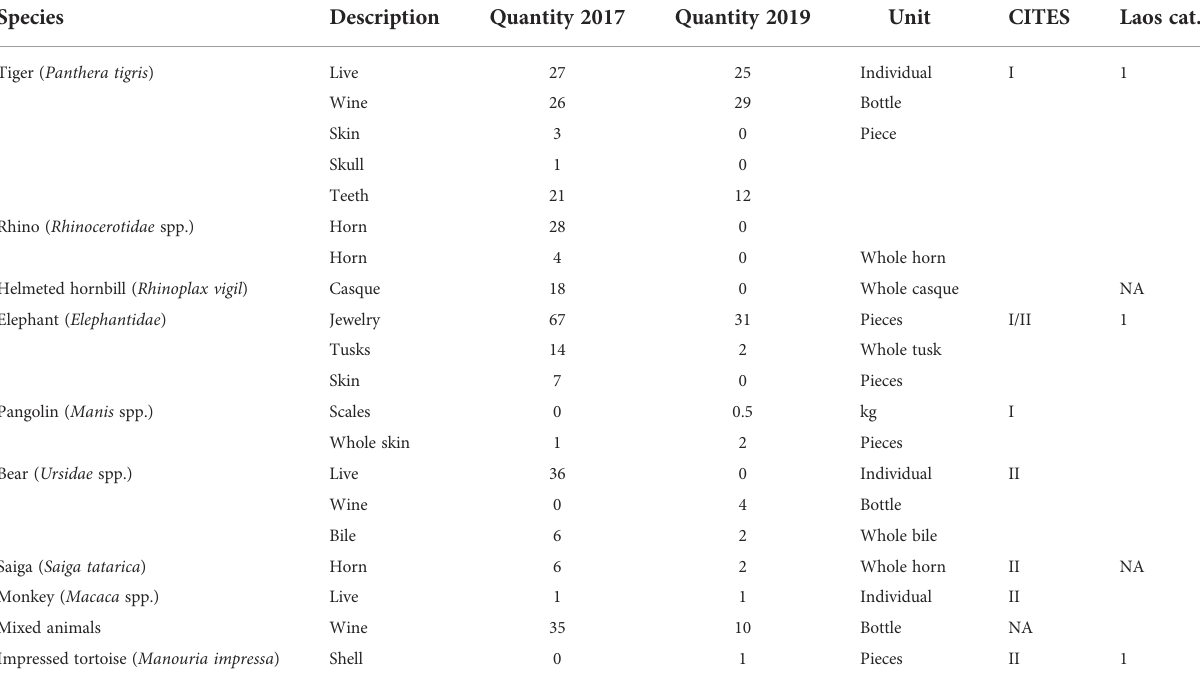
TABLE 1 Open wildlife trade in the Golden Triangle SEZ, Laos — the endangered species in the casino, wildlife shops, and wild meat restaurants in 2017 and 2019. Species